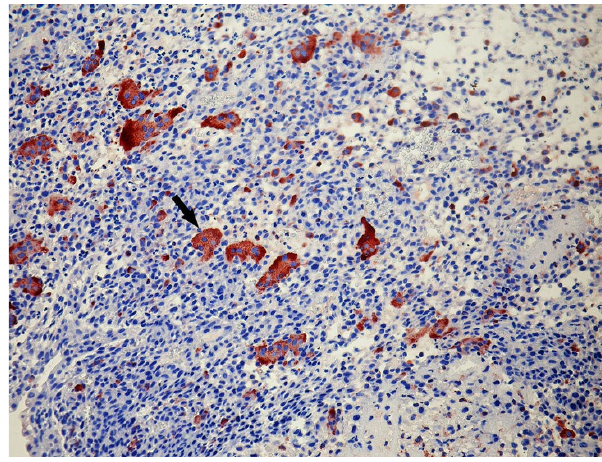
Figure 4 Giant cells showing cytoplasmic staining with TRAP (arrow) in Case 1